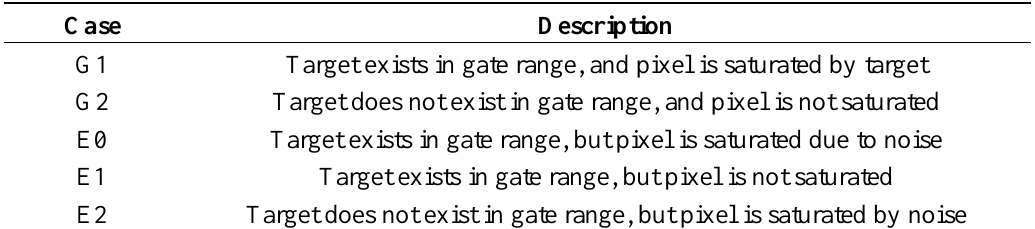
Table 7. Descriptions of cases in Table